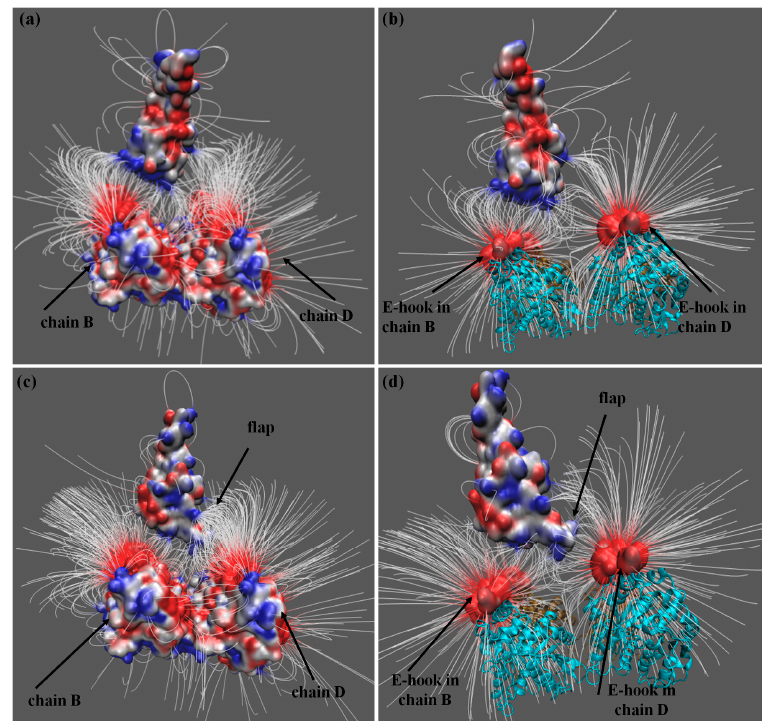
Figure 2. Electrostatic potential mapped onto the MTBD surface along with the electrostatic field lines around and between the corresponding MTBD and tubulins calculated with the corresponding MTBD separated from tubulins by 35 Å. Electrostatic field lines between MTBDs and all the residues of tubulins, including E-hooks, are shown in panel ( a ) for cytoplasmic dynein and ( c ) for axonemal dynein. Panels ( b ) and ( d ) present the electrostatic field lines between only E-hooks and the MTBDs of cytoplasmic and axonemal dyneins, respectively. The red and blue colors show the negative and positive electrostatic fields, respectively. Tubulins are shown with cyan ribbons.